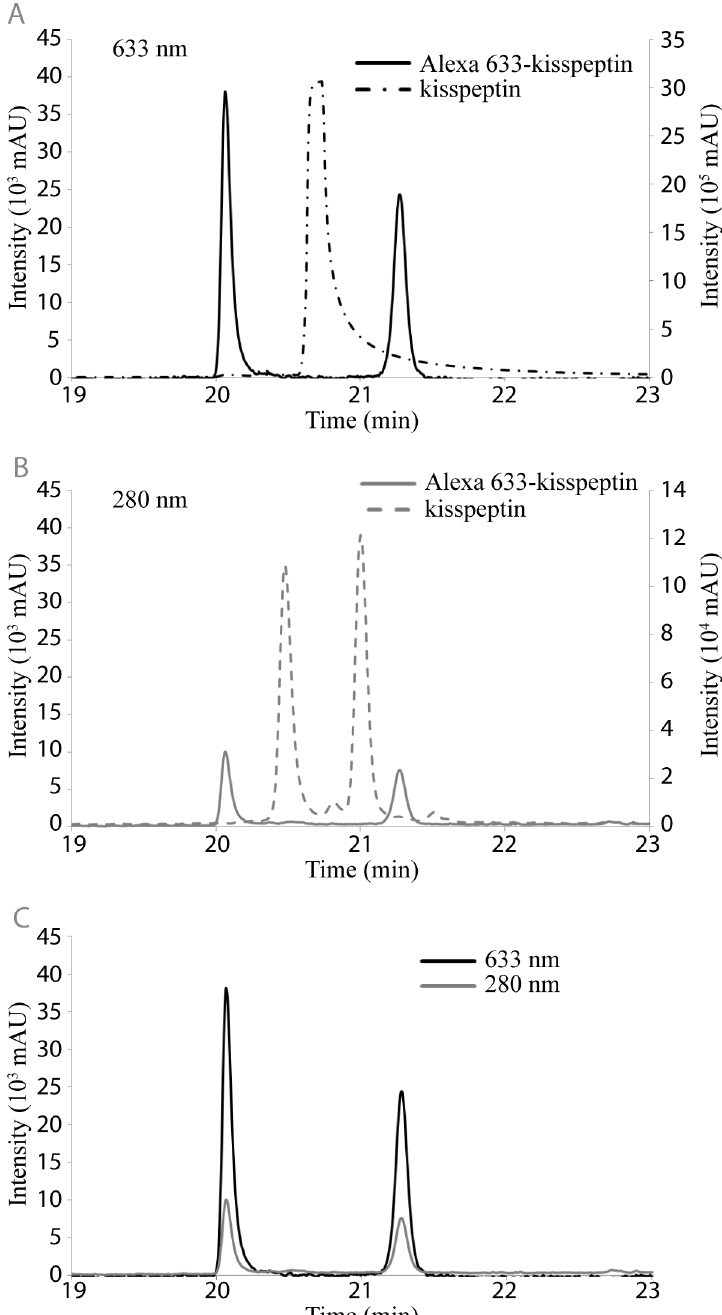
Fig 3. The fluorescent dye Alexa 633 successfully conjugates to the kisspeptin after maleimide-based reaction. HPLC confirmed the successful conjugation of kisspeptin with Alexa 633. Generation of the Alexa 633-kisspeptin probe results in a notable shift in elution time, measured at both 633 nm (A) and 280 nm (B) with no detectable unlabeled peptide. Elution peaks at both wavelengths are identical (C), indicating successful conjugation of the Alexa 633 dye and